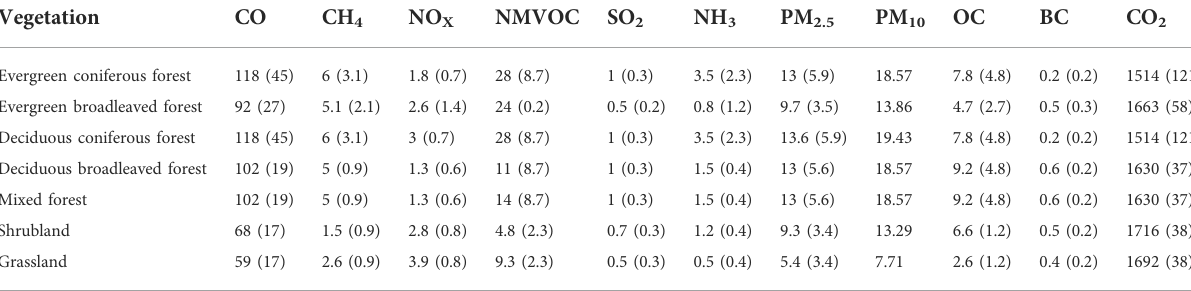
TABLE 2 Emission factor assigned to the various land cover types (g/kg dry